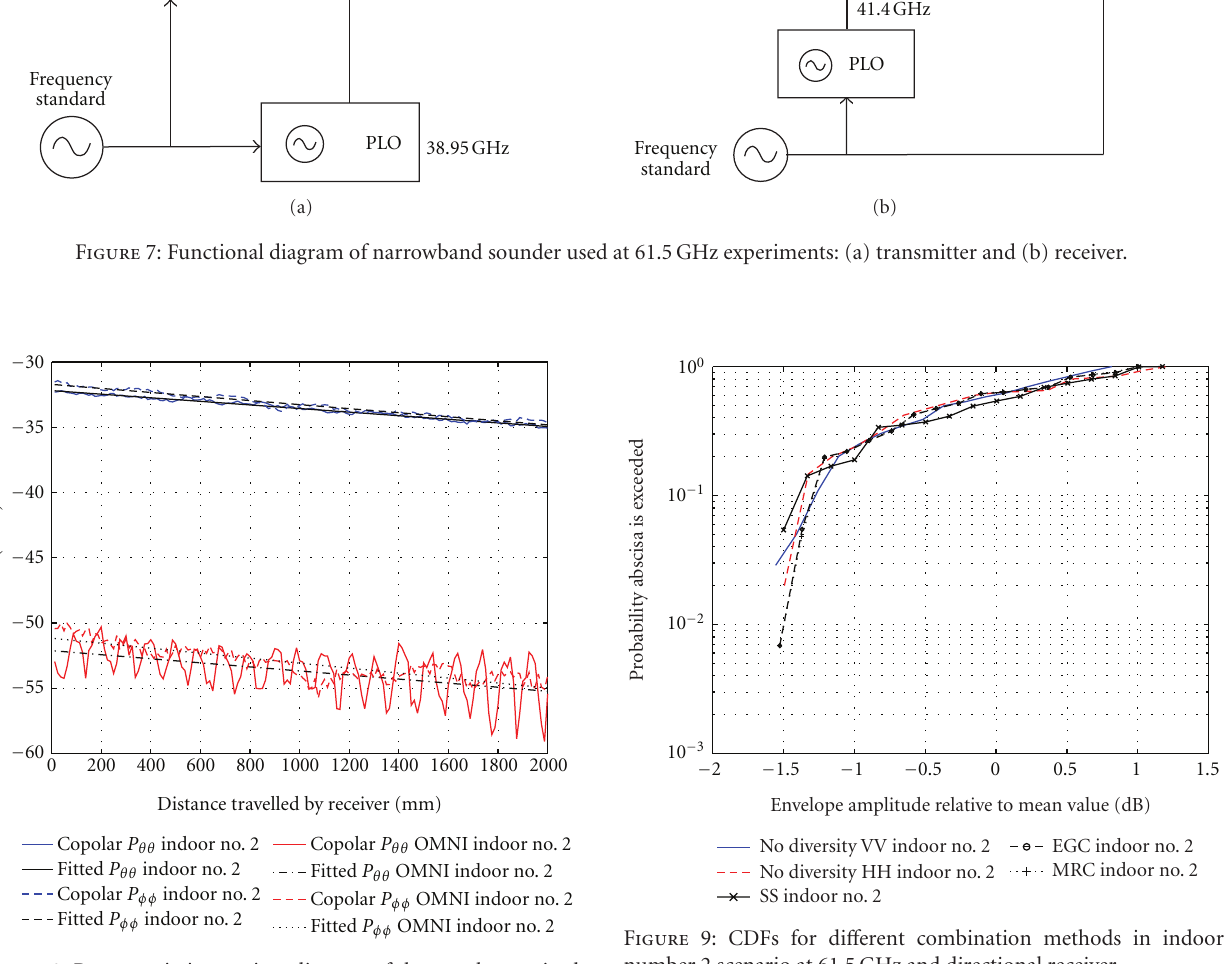
Figure 8: Power variation against distance of the copolar received signal envelope in indoor number 2 scenario at 61.5 GHz, and power decay law fitting.